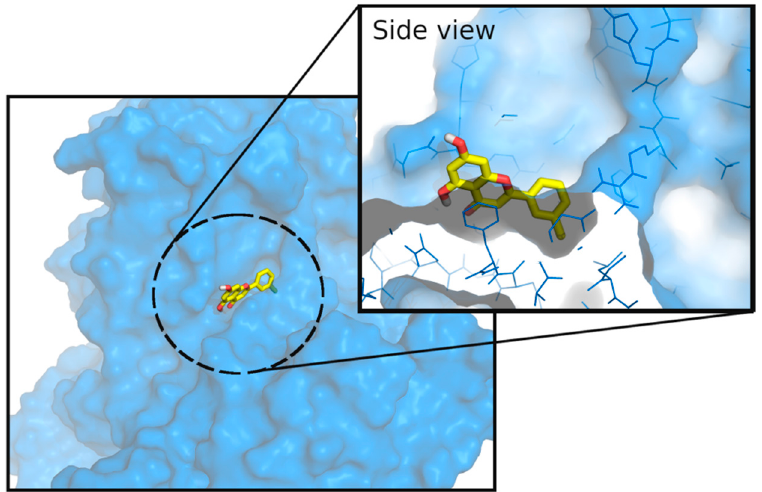
Figure 3. X-ray structure of GPa protein (from 6Y55) in blue, and its co-crystallised ligand in yellow. The ligand is bound at the inhibitor binding site (or caffeine binding site).